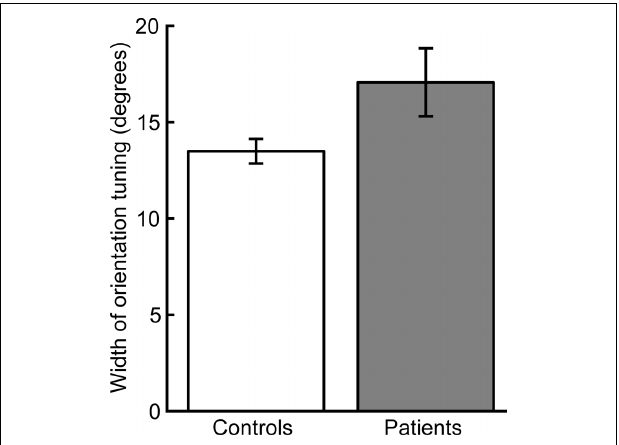
FIGURE 4 | Correlation of orientation tuning with visual cortical GABA levels. Orientation tuning curve widths for individual subjects are plotted as a function of visual cortical GABA concentration (normalized to creatine levels, GABA/Cr).There is a trend in the data toward a negative correlation between orientation tuning width and the GABA/Cr